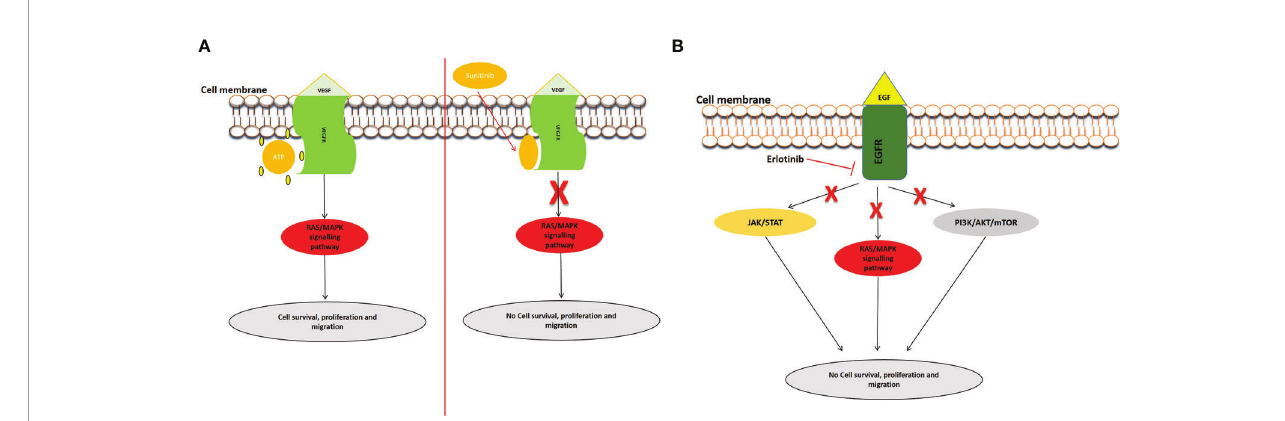
FIGURE 1 | Examples of inhibition of the VEGFR and EGFR signaling pathways. (A) Inhibition of VEGFR signal transduction by sunitinib. After the entry of sunitinib into the cytoplasm, it competitively binds at the ATP site of VEGFR, consequently inhibiting the activation of the pathway. (B) Mechanism of action of Tyrosine kinase inhibitor, erlotinib. Erlotinib is a small molecule that acts as an ATP analogue and inhibits EGF signaling by binding to receptor tyrosine kinases (RTKs), and inhibits the activation of downstream signaling